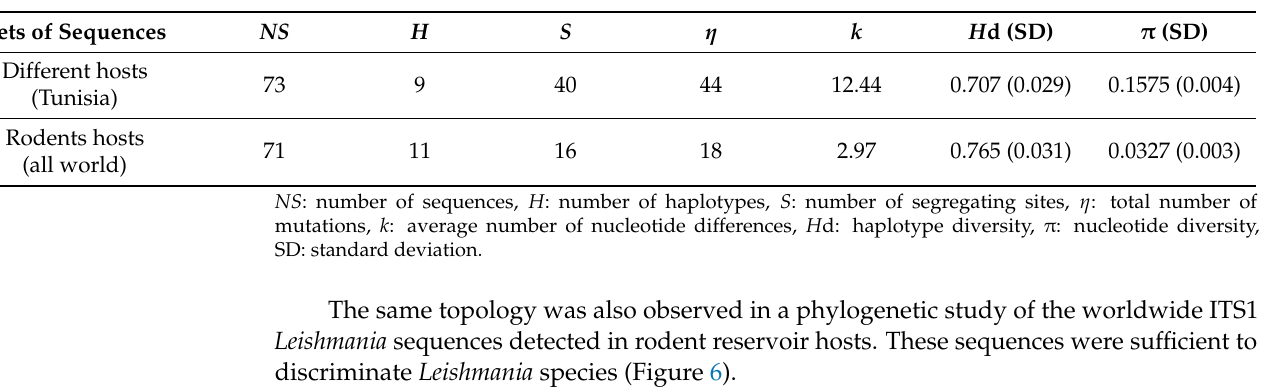
Table 2. Indices of genetic diversity for the two studied sets of Leishmania sequences.